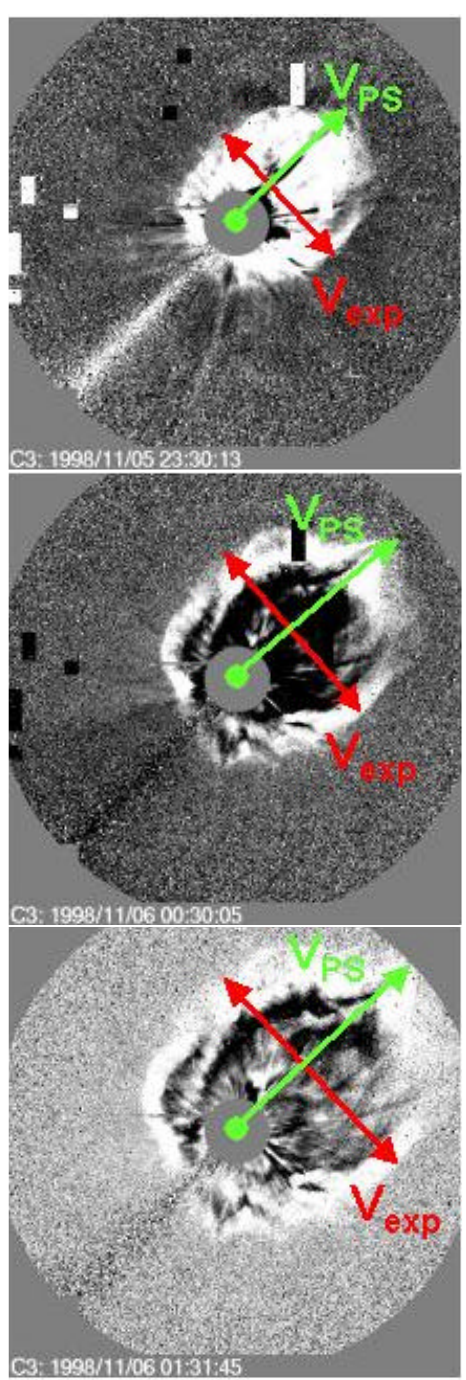
Fig. 2. The halo CME of 5 November 1998 (E90), for illustration of the different meaning of expansion speed V exp and the plane of . In this case we measured V = 1116 the sky speed V PS . In this case we measured V exp =1116km/s, PS exp and V PS =1118km/s, A shock arrived at the Earth 55.6h later, i.e. about 7h earlier than we predicted (case E20 in Table 2). A severe magnetic storm (D st − 142nT) peaked 14h after shock arrival. The –142 nT) peaked st images are running differences between LASCO C3